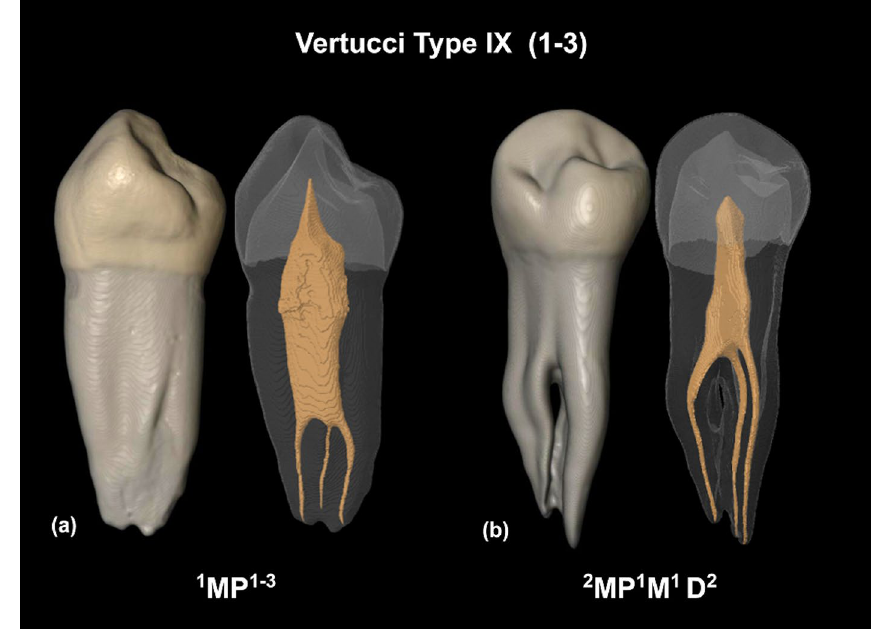
Figure 6. Micro-CT images showing the root canal configuration Vertucci’s type IX (1–3) in two teeth differently classified using Ahmed’s criteria. ( a ) 1 MP 1–3 : A single-rooted mandibular first premolar with three root canals, ( b ) 2 MP 1 M 1 D 2 : A double-rooted mandibular first premolar with three root canals. D distal; M mesial; MP mandibular first premolar (Images obtained using the CTAn v.1.12 software,